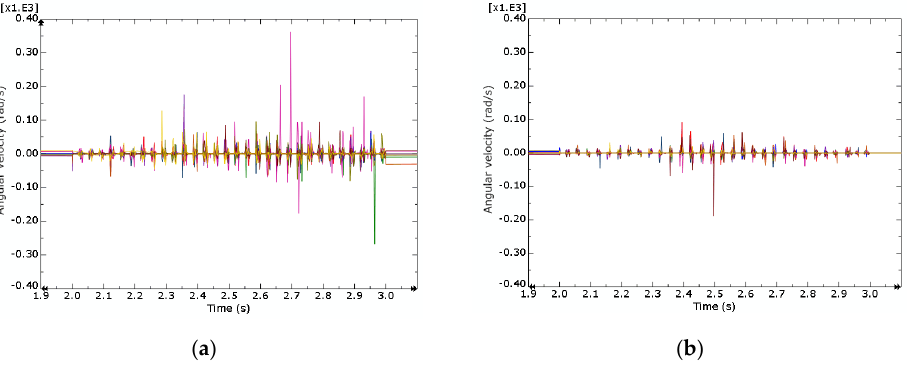
Figure 6. Angular velocity of different mixtures: ( a ) AC 11 in X-direction; ( b ) PA 11 in X-direction.